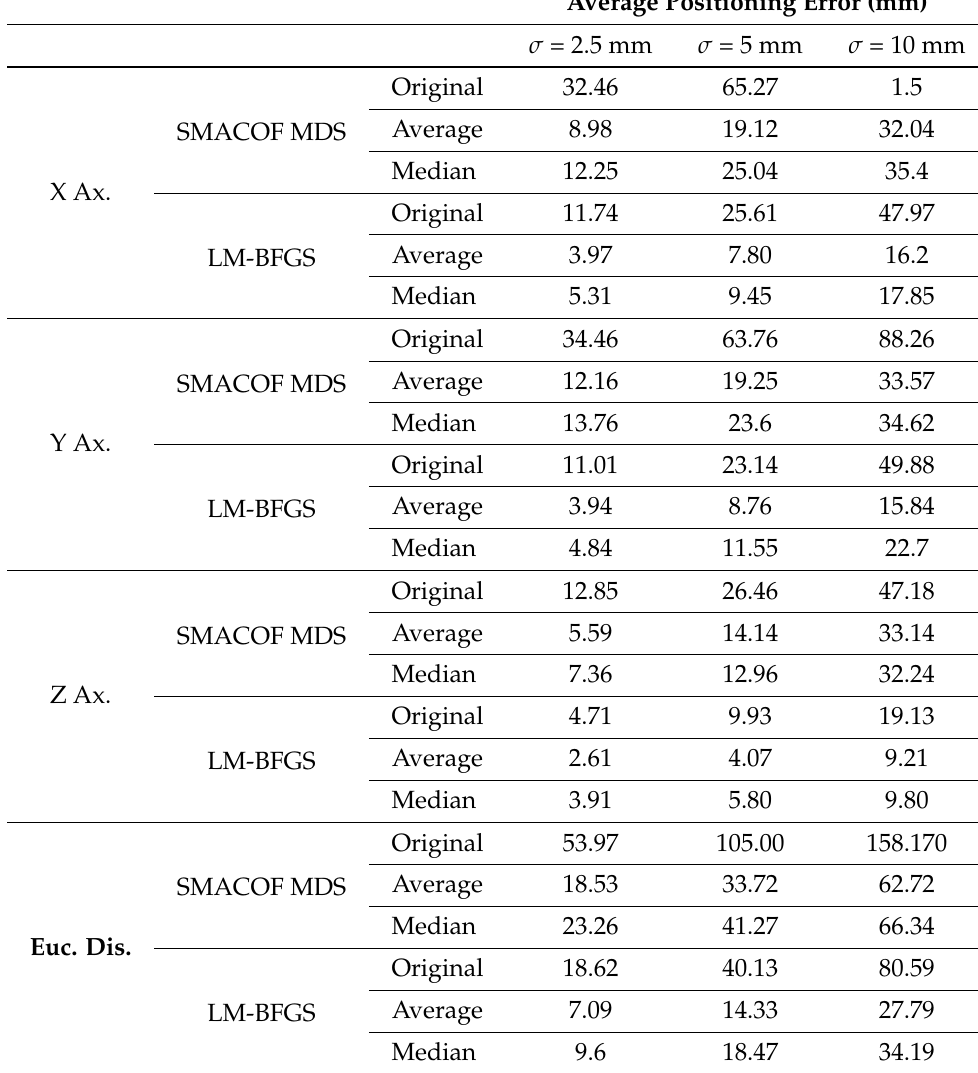
Table 6. Average trajectory error for the circle XZ gesture, with no smoothing (Original) and with 11th order ( M = 11) moving-average (Average) and moving-median (Median) smoothing filters, for SMACOF MDS and LM-BFGS optimization